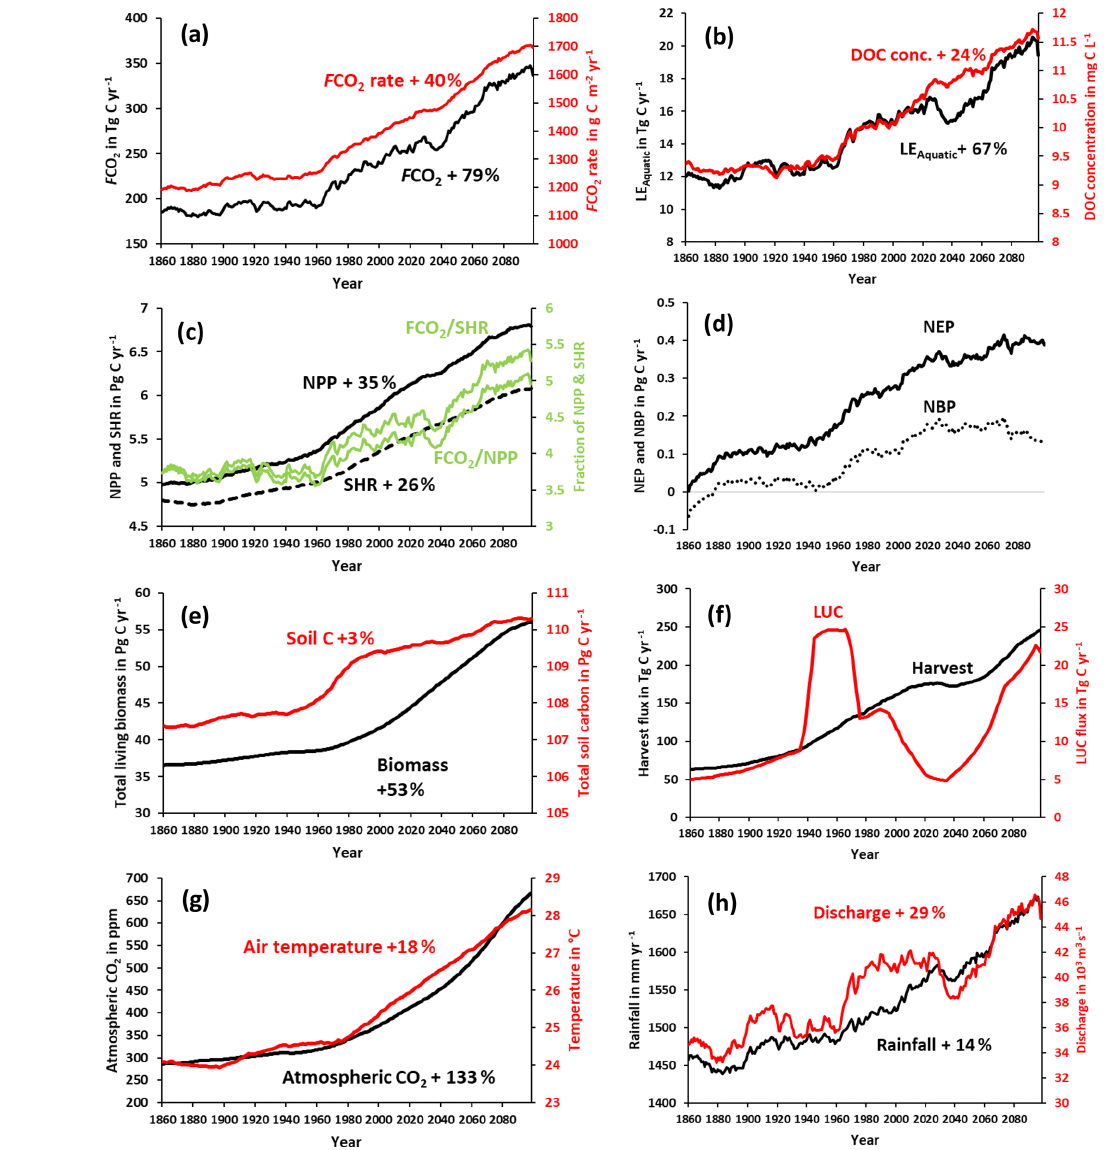
Figure 9. Simulation results for various C fluxes and stocks from 1861–2099 using IPSL-CM5A-LR model outputs for RCP6.0 (Frieler et al., 2017). All panels except for atmospheric CO 2 , biomass, and soil C correspond to 30-year running means of simulation outputs. This was done in order to suppress interannual variation, as we are interested in longer-term